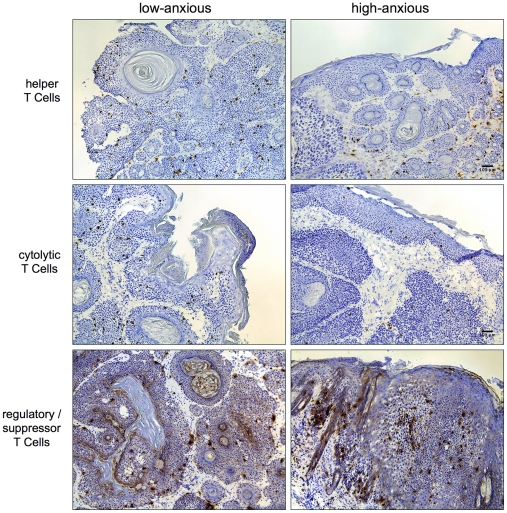
Photomicrographs showing the effects of anxiety phenotype on tumor infiltrating helper (Th), cytolytic (CTL), and regulatory (Treg) T cells.Immunohistochemical staining for CD4 (top row), CD8 (middle row), and CD25 (bottom row) was used to enumerate (counts shown in Fig. 4) tumor infiltrating T cells from low- (left column) and high- (right column) anxious mice at week 31. Scale bar denotes 100 µm.